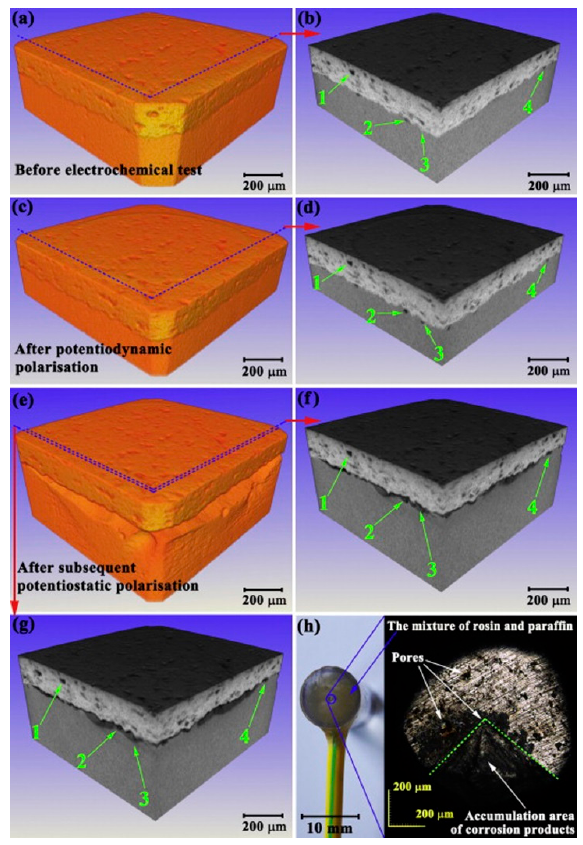
Figure 7. ( a – g ) 3D XRT images showing the substrate corrosion evolution beneath the coating during three stages, and ( h ) coating surface morphology showing the accumulation of corrosion products [124].